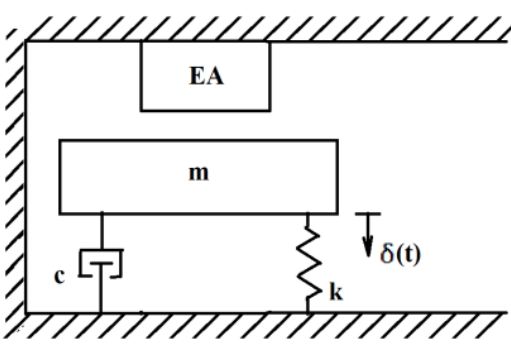
Figure 1. Sketch of damped, forced Hertzian oscillator with an asymmetric EA. Where the dot denotes differentiation with respect to time t , and δ is the normal displace- ment of the rigid mass m , c is the damping coefficient, k is the constant of elasticity given by the Hertzian theory, N s is the static normal load, σ is the amplitude, and ν is the frequency of the harmonic excitation load, respectively, and F em is the electromagnetic